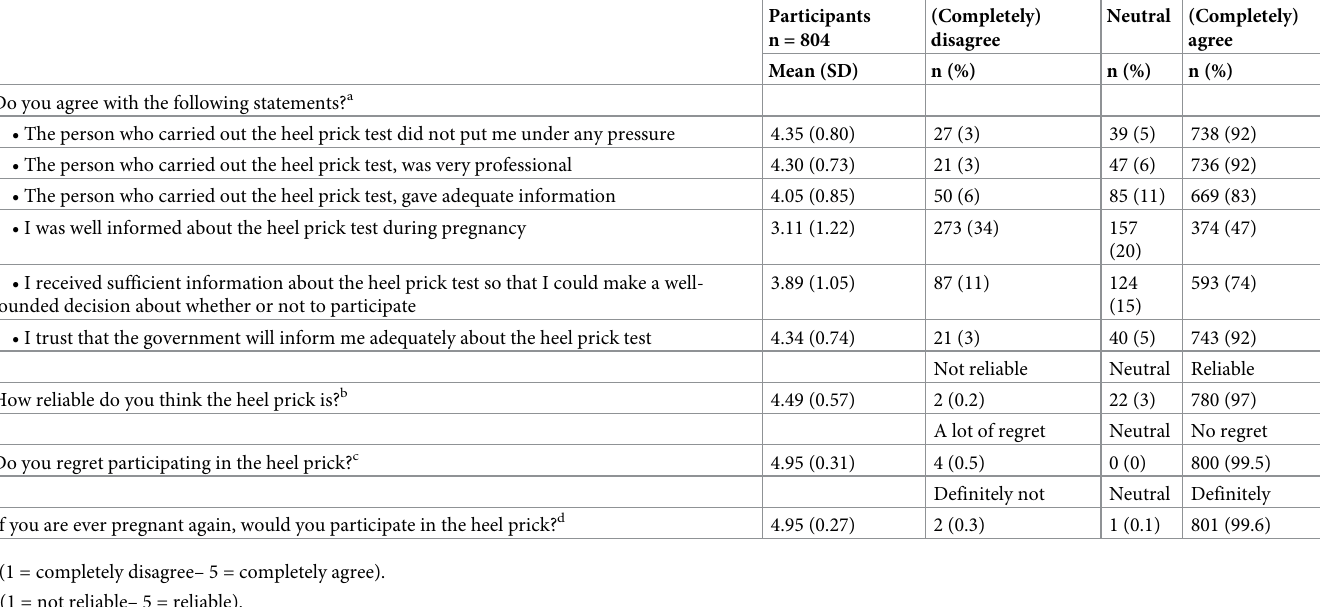
Table 4. Parents’ views on current Dutch newborn bloodspot